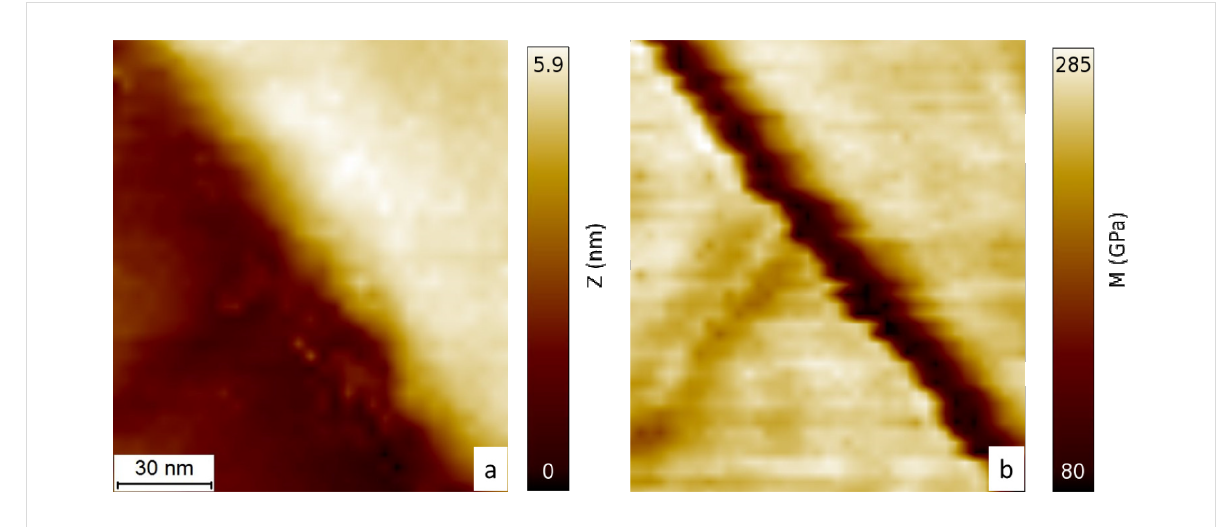
Figure 7: Topography (a) and indentation modulus (b) map of the area around a GaN